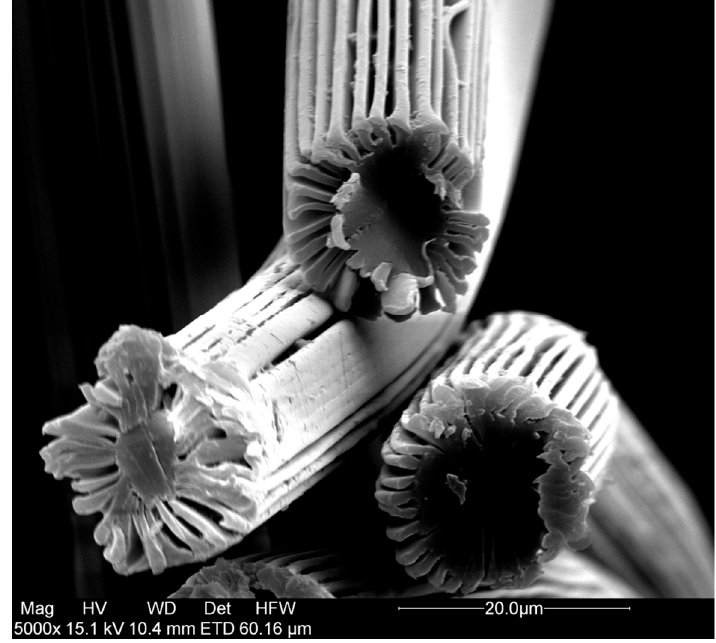
Figure 1. SEM photograph of a representative fiber sample.